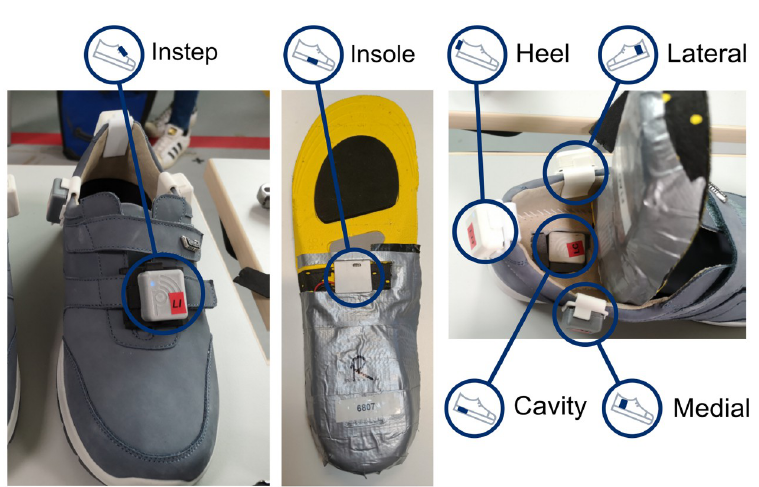
Fig 2. Sensor placement of the six shoe sensors. The insole sensor (center) was embedded in a purpose-built insole. The cavity sensor was placed in a cavity in the sole of the custom shoe (right). All other sensors were attached with 3D- printed